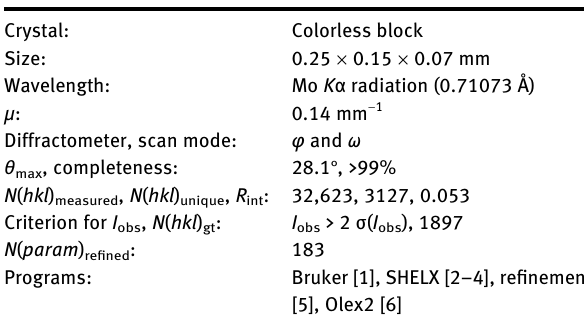
Table  : Data collection and